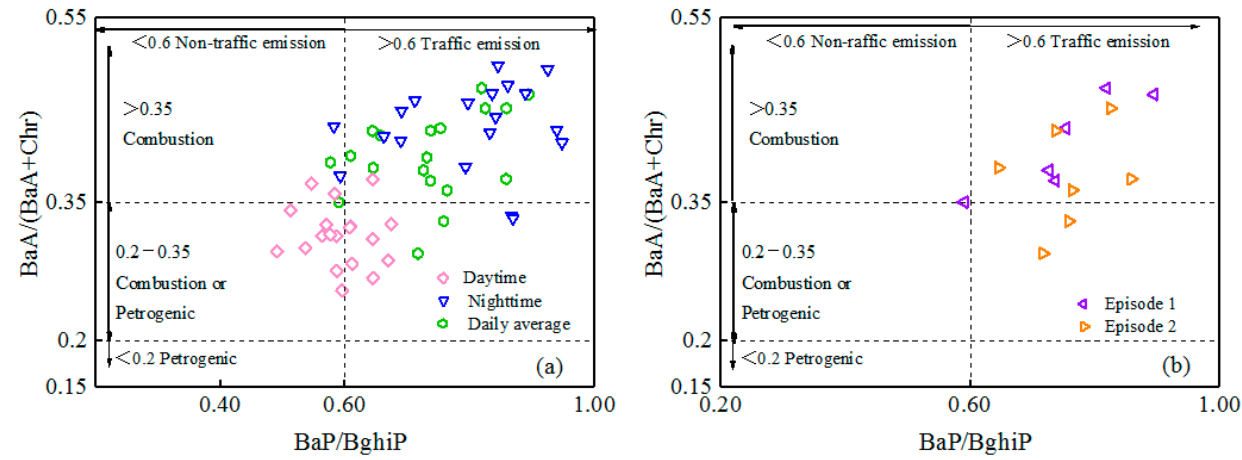
Figure 12. Variation of BaP/BghiP and BaA(BaA + Chr) during the monitoring period: ( a ) BaP/BghiP VS. BaA/(BaA + Chr), ( b ) BaP/BghiP VS. BaA/(BaA + Chr).